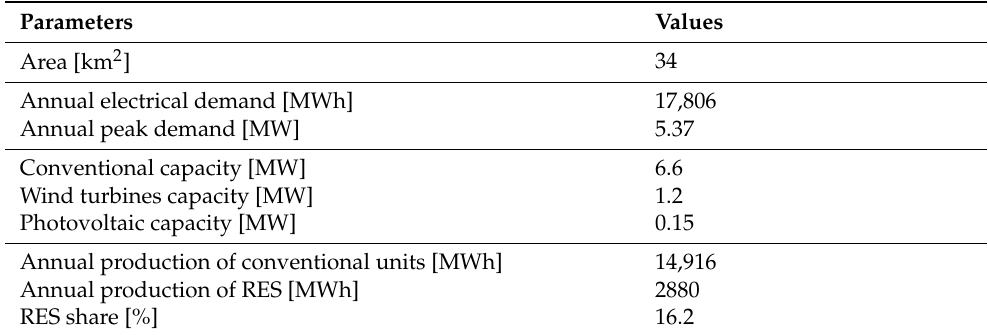
Table 1. General information and electricity production/consumption by conventional units and RES on Patmos (2020).